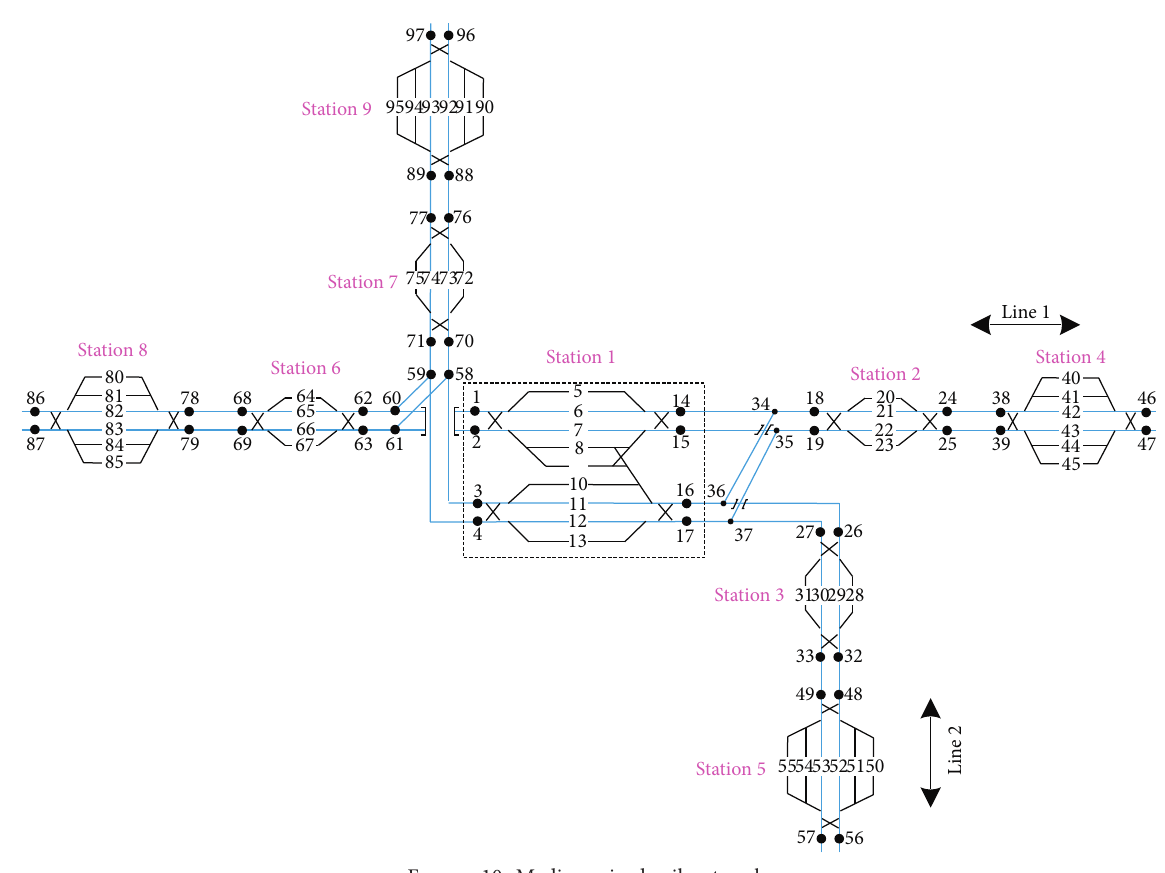
Figure 10: Medium-sized rail network.